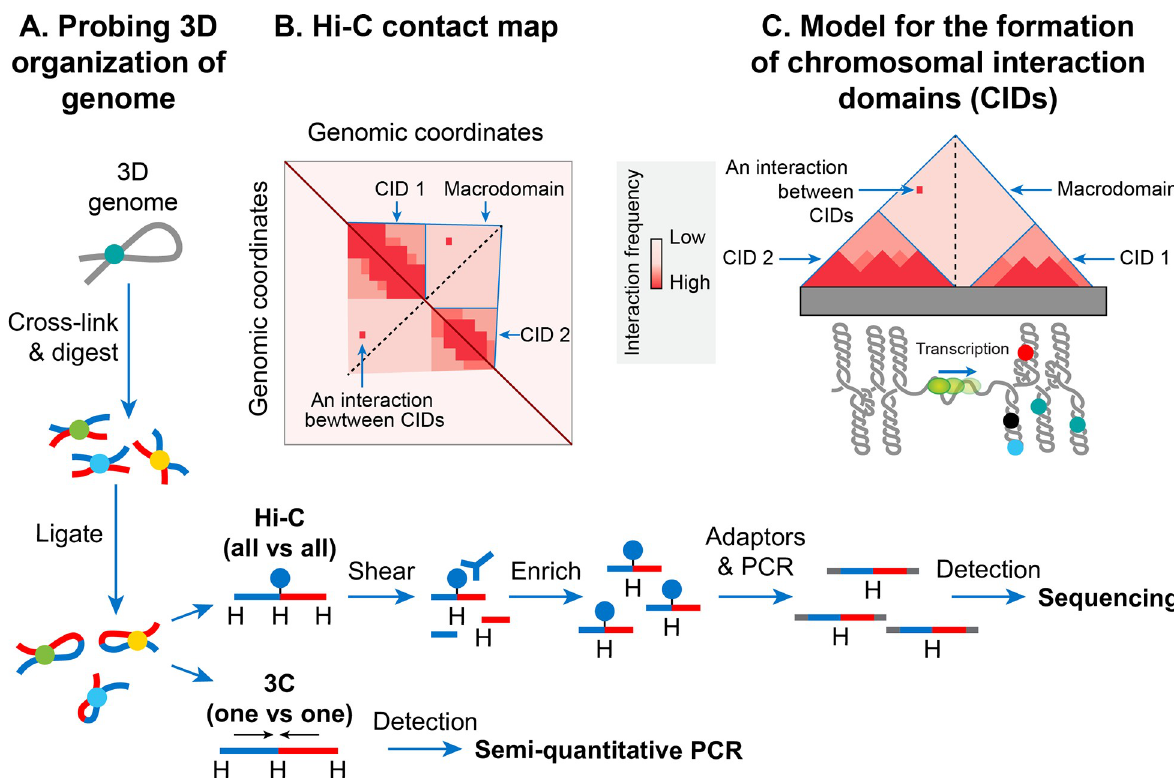
Fig 8. Nucleoid is spatially organized into chromosomal interactions domains (CIDs) and macrodomains. A. Chromosome conformation capture (3C) methods probe 3D genome organization by quantifying physical interactions between genomic loci that are nearby in 3D-space but may be far away in the linear genome. A genome is cross-linked with formaldehyde to preserve physical contacts between genomic loci. Subsequently, the genome is digested with a restriction enzyme. In the next step, a DNA ligation is carried out under diluted DNA concentrations to favor intra-molecular ligation (between cross-linked fragments that are brought into physical proximity by 3D genome organization). A frequency of ligation events between distant DNA sites reflects a physical interaction. In the 3C method, ligation junctions are detected by the semi- quantitative PCR amplification in which amplification efficiency is a rough estimate of pairwise physical contact between genomic regions of interests and its frequency. The 3C method probes a physical interaction between two specific regions identified a priori, whereas its Hi-C version detects physical interactions between all possible pairs of genomic regions simultaneously. In the Hi-C method, digested ends are filled in with a biotinylated adaptor before ligation. Ligated fragments are sheared and then enriched by a biotin-pull down. Ligation junctions are then detected and quantified by the paired-end next-generation sequencing methods. B. Hi-C data are typically represented in the form of a two-dimensional matrix in which the x-axis and y-axis represent the genomic coordinates. The genome is usually divided into bins of a fixed size, e.g., 5-kb. The size of bins essentially defines the contact resolution. Each entry in the matrix, m ij , represents the number of chimeric sequencing reads mapped to genomic loci in bins i and j. A quantification of the reads (represented as a heatmap) denotes the relative frequency of contacts between genomic loci of bins i and j. A prominent feature of the heatmap is a diagonal line that appears due to more frequent physical interaction between loci that are very close to each other in the linear genome. The intensity as we move away from this diagonal line represents the relative frequency of physical interaction between loci that are far away from each other in the linear genome. Triangles of high-intensity along the diagonal line represent highly self-interacting chromosomal interaction domains (CIDs) that are separated by a boundary region that consists of a smaller number of interactions. C. In many bacterial species including E . coli , it appears that supercoiled topological domains organize as CIDs. Plectonemic supercoiling promotes a high level of interaction among genomic loci within a CID, and a plectoneme-free region (PFR), created due to high transcription activity, acts as a CID boundary. Nucleoid-associated proteins, depicted as closed circles, stabilize the supercoiling-mediated interactions. The actively transcribing RNA polymerase (depicted as a green sphere) in the PFR blocks dissipation of supercoiling between the two domains thus acts as a supercoiling diffusion barrier. The size of the CIDs ranges between 30–400 kb. Several triangles (CIDs) merge to form a bigger triangle that represents a macrodomain. In other words, CIDs of a macrodomain physically interact with each other more frequently than with CIDs of a neighboring macrodomain or with genomic loci outside of that macrodomain. A macrodomain may comprise of several CIDs. For simplicity, a macrodomain comprising of only two CIDs is